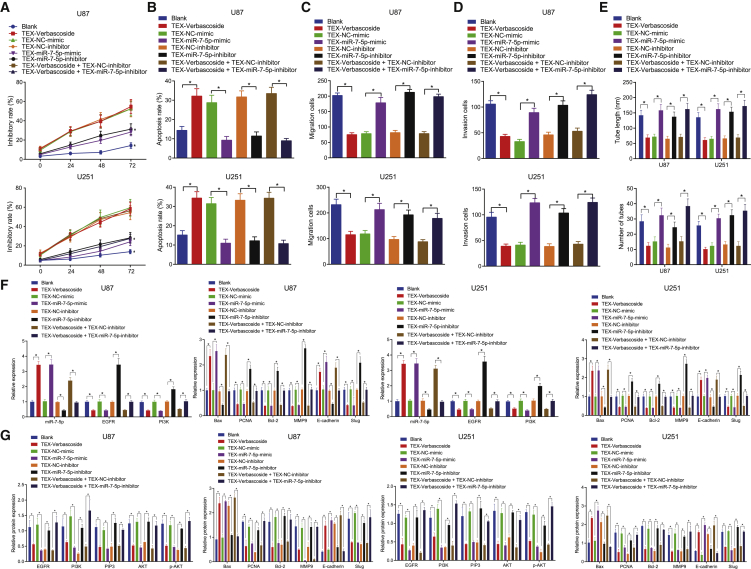
Exosome containing miR-7-5p inhibits the GBM cell proliferation, migration, invasion, and microtubule formation by inhibiting the EGFR/PI3K/Akt signaling pathwayU87 and U251 cells were co-cultured with TEXs from VB-treated cells, from miR-7-5p-mimic-transfected cells, or from miR-7-5p-inhibitor-transfected cells. (A) Cell proliferation was detected by MTT assay. (B) Cell apoptosis was detected by flow cytometry. (C) Cell migration ability was detected by Transwell assay. (D) Cell invasion ability was detected by Transwell assay. (E) Angiogenesis of GBM cells was measured by microtubule formation. (F) The mRNA expression of related proteins (EGFR, PI3K, Bax, PCNA, Bcl-2, MMP9, E-cadherin, and Slug) was detected by qRT-PCR. (G) The expression of related proteins (EGFR, PI3K, PIP3, Akt, p-Akt, Bax, PCNA, Bcl-2, MMP9, E-cadherin, and Slug) was detected by western blot analysis. Data were shown as mean ± standard deviation of three technical replicates. ANOVA of repeated measurement was used for data comparison in (A). Unpaired t test was used for data comparison between two groups and one-way ANOVA for data comparison among multiple groups, with Tukey’s post-test test. ∗p < 0.05 compared with the corresponding control group.